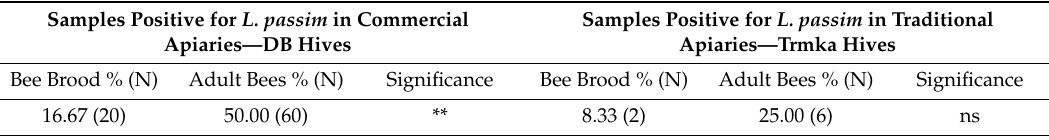
Table 3. Comparison of prevalence of L. passim in larvae and adult bees in commercial and traditional hives (trmka hives).